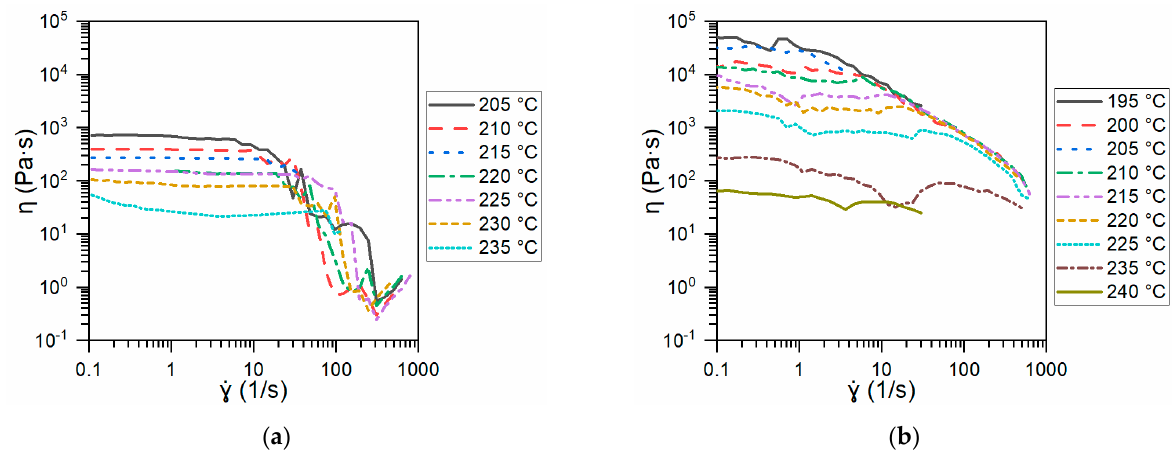
Figure 6. Viscosity ( η ) as function of the temperature and the shear rate ( ɣ̇ ) for ( a ) Ninjaflex and ( b ) the SH-TPU.